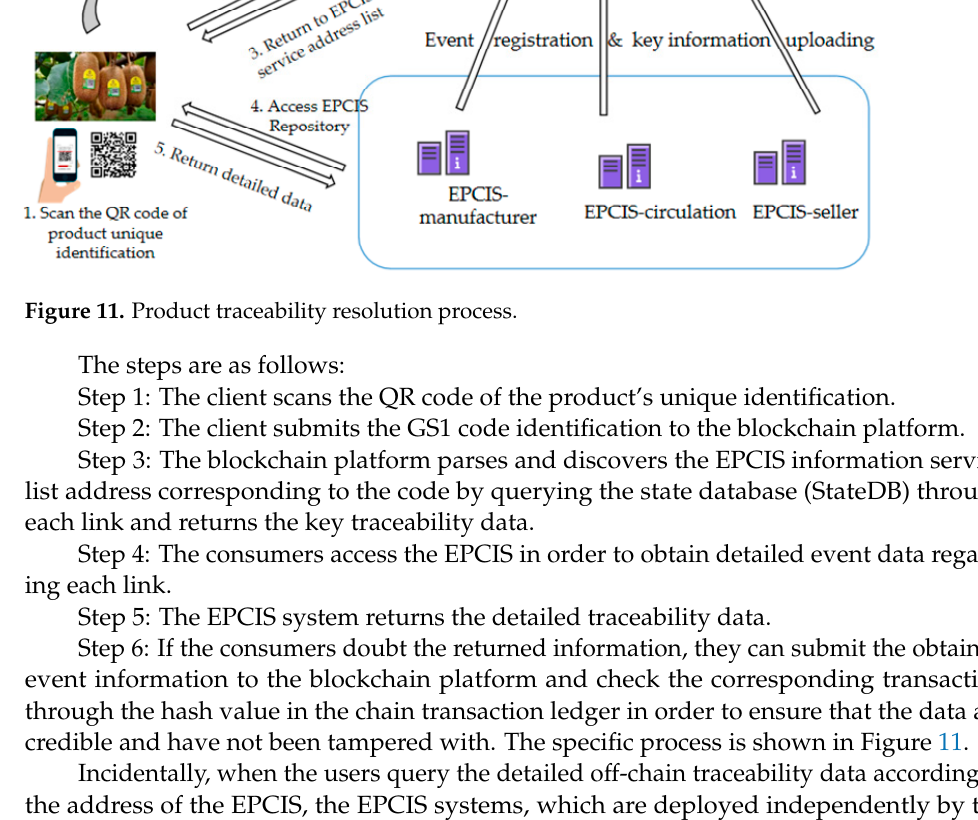
Table 5. Off-chain EPCIS software environment.